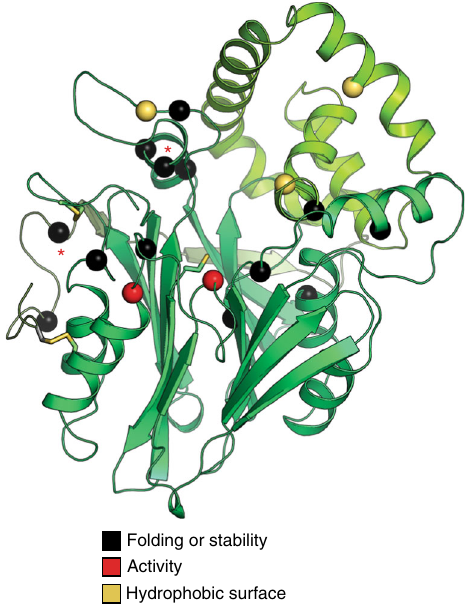
Fig. 6 Structural mapping of disease mutations. Disease mutations are colored based on their expected effect on the enzyme. Black spheres represent disease mutations that likely disrupt the folding or stability of the enzyme, red spheres are mutations that affect the active site of aCDase, and yellow spheres are mutations that affect the hydrophobic surface. The α -subunit of the mature enzyme is in light green and the β -subunit is in green. Cys 143 is shown as sticks. Locations of observed SMA-PME missense mutations in the structure are labeled with a red asterisk; all other locations are missense mutations causing FD